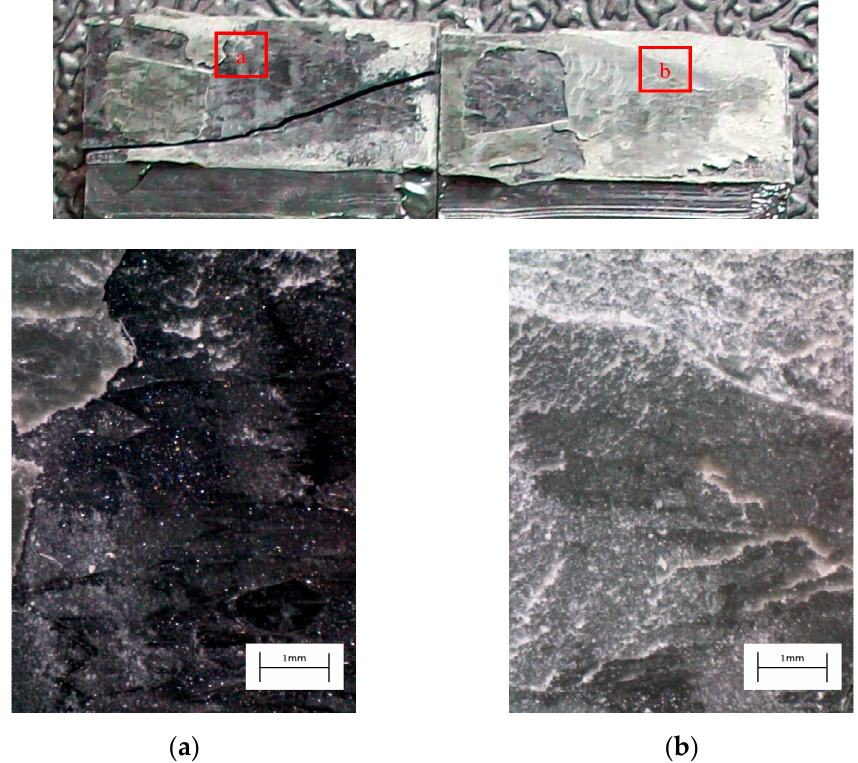
Figure 12. Fracture surface of a specimen pretreated with APPT with D = 10 mm and v = 100 mm/s and subjected to quasi-static tensile test, with magnified details ( a ) and ( b ) acquired by micro- scope.